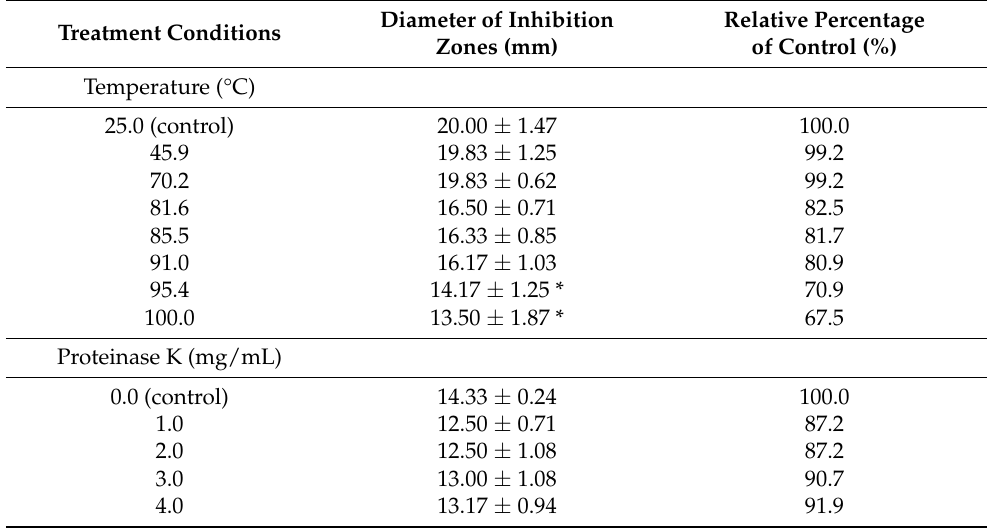
Table 2. Biochemical characterization of the antibacterial activity of strain F9 lipopeptide extract. Treatment